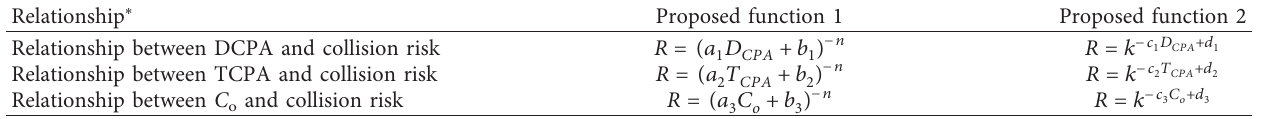
Table 3: Functions of relationships between DCPA, TCPA, C o , and collision risk. Relationship ∗ Proposed function 1 Proposed function 2 Relationship between DCPA and collision